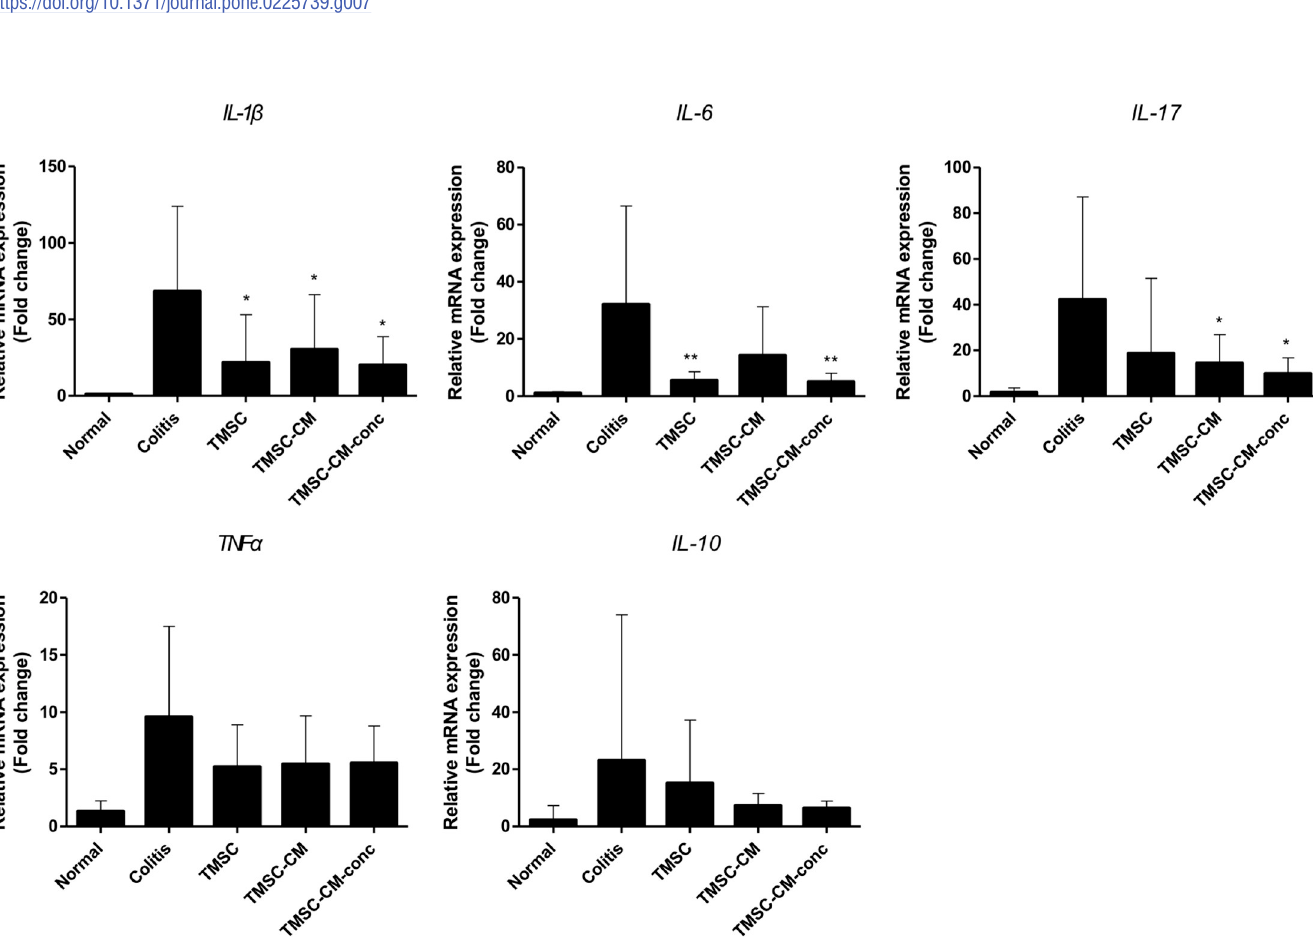
Fig 8. Cytokine levels of colon tissue. The level of IL-1 β was significantly lower in TMSC, TMSC-CM, and TMSC-CM-conc groups compared to the colitis control group. (mean with standard deviation, � p < 0.05, �� p < 0.01) IL, interleukin; TNF, tumor necrosis factor.